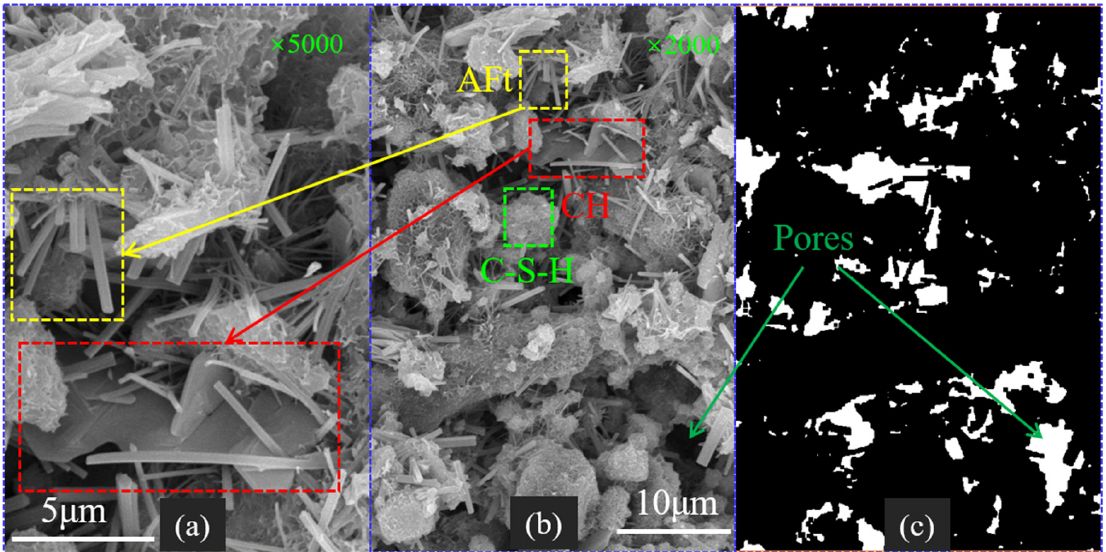
Figure 5. SEM image of LMPGCB of group B; ( a ) ×5000 magnification, ( b ) ×2000 magnification, and ( c ) binarization image.